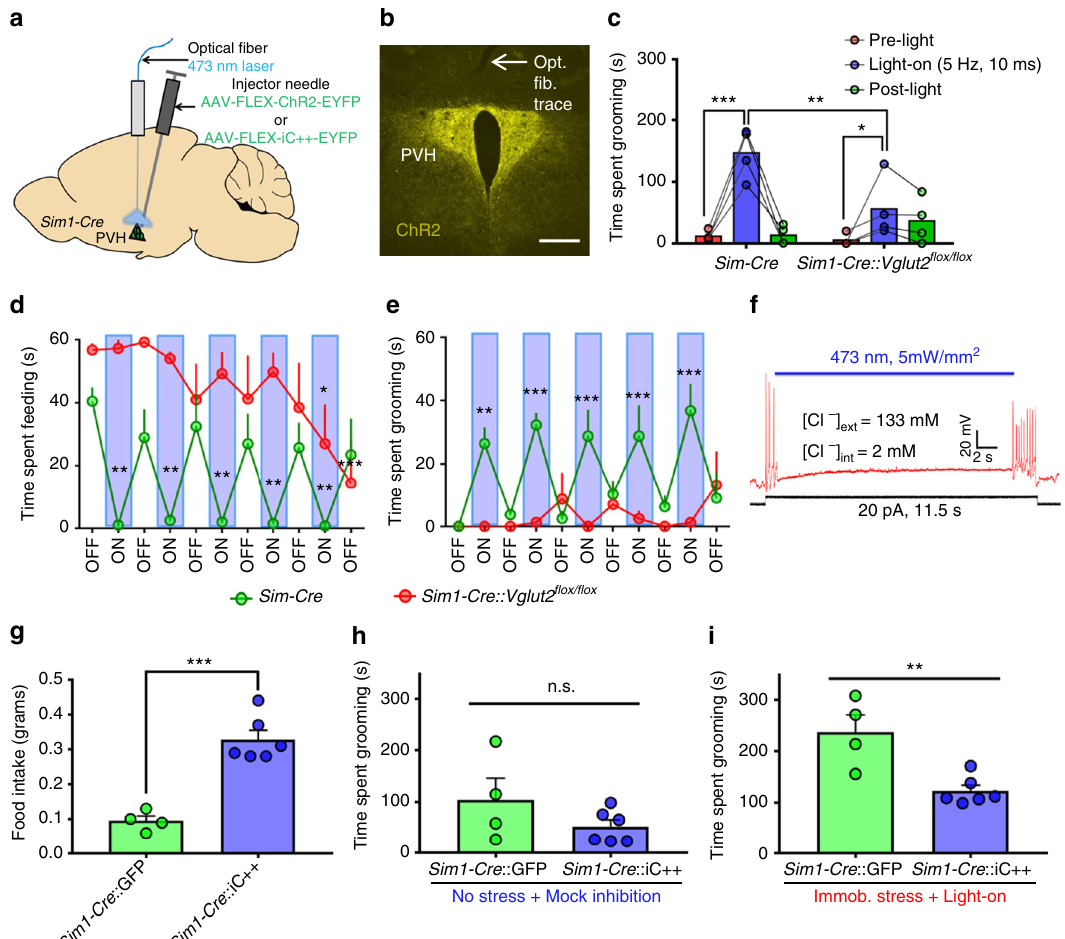
Fig. 7 Photostimulation of PVH Sim1 neurons induces grooming behavior and competes with fast-refeeding, and inhibition increases feeding and reduces stress-induced grooming. a Experimental schematic. b ChR2-EYFP expression in PVH Sim1 neurons and optical fi ber implantation (opt. fi b. trace, arrow) above PVH. Scale bar = 300 µ m. c Grooming time before (pre-light), during (light-on), and after (post-light) 5 Hz, 10 ms photostimulation of PVH Sim1-ChR2 neurons in Sim1-Cre ( n = 4) and Sim1-Cre::Vglut2 fl ox/ fl ox ( n = 4) mice. Two-way repeated measures ANOVA followed by Dunnett ’ s multiple comparisons test (interaction F [2, 12] = 10.77, P = 0.0021; genotype F [1, 6] = 2.265, P = 0.1831; light F [2, 12] = 30.2, P < 0.0001; subjects (matching) F [6, 12] = 2.514, P = 0.0821. Sim1-Cre [pre-light vs. light-on] *** p < 0.0005; Sim1-Cre::Vglut2 fl ox/ fl ox [pre-light vs. light-on] * p < 0.05; Sidak ’ s multiple comparisons: Sim1-Cre vs. Sim1-Cre::Vglut2 fl ox/ fl ox [light-on] ** p < 0.005). d Time spent feeding after a fast during alternating, 1 min-light off/on events in Sim1-Cre ( n = 4) and Sim1-Cre::Vglut2 fl ox/ fl ox ( n = 4) mice (light-on = 5 Hz, 10 ms). e Time spent grooming in the same experiment. d , e Data are presented as mean ± s.e.m. Two-way repeated measures ANOVA followed by Dunnett ’ s multiple comparisons test d , interaction F [10, 60] = 4.594, P < 0.0001; light F [10, 60] = 4.265, P = 0.0002; genotype F [1, 6] = 15.95, P = 0.0072; subjects (matching) F [6, 60] = 5.389, P = 0.0002. Sim1-Cre [ fi rst light-off vs. On-1, On-2, On-3, On-4, On-5] ** p < 0.005; Sim1-Cre::Vglut2 fl ox/ fl ox [ fi rst light-off vs. last light-on] * p < 0.05; ( fi rst light-off vs. last light-off) *** p < 0.0005. e , interaction F [10, 60] = 5.418, P < 0.0001; light F [10, 60] = 3.68, P = 0.0007; genotype F [1, 6] = 12, P = 0.0134; subjects (matching) F [6, 60] = 3.74, P = 0.0032. Sim1-Cre ( fi rst light-off vs. On-1) ** p < 0.005; ( fi rst light-off vs. On-2, On-3, On-4, On-5) *** p < 0.0005). f Silencing PVH Sim1-iC ++ neurons with blue light blocks action potentials induced by depolarizing current injection. g 30 min food intake during optical inhibition of PVH with blue light in Sim1-Cre ::GFP control and iC++ mice. h Time spent grooming during 15 min of mock inhibition following no acute stress in the same mice. i Time spent grooming during 15 min of blue-light inhibition following 10 min of immobilization stress in the same mice. g – i Two-tailed Student's t -tests. g t = 6.715, df = 8, *** p = 0.0002; h t = 1.415, df = 8, p = 0.1948; i t = 3.855, df = 8, ** p = 0.0048